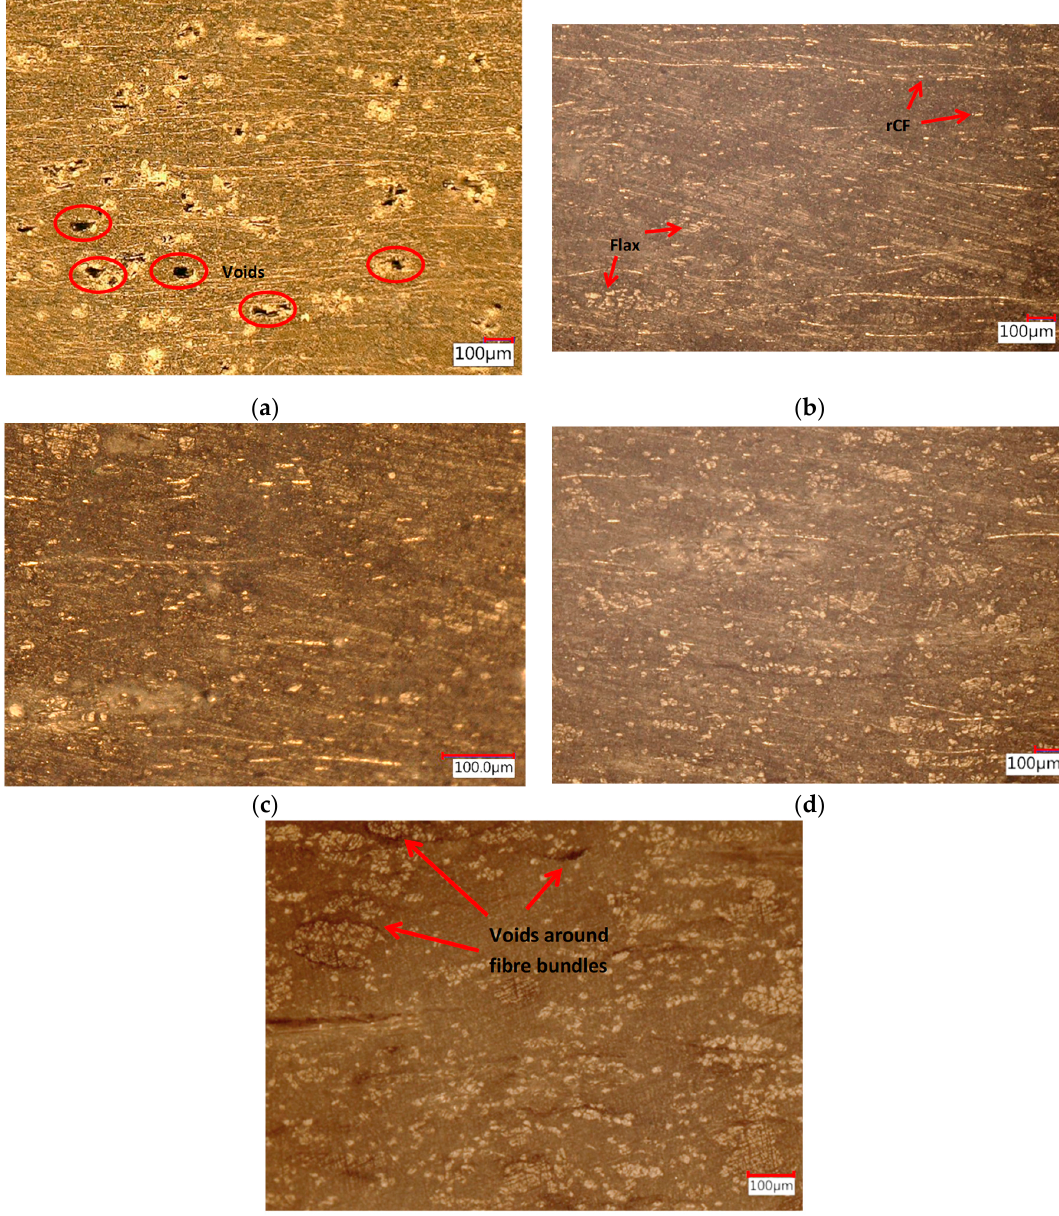
Figure 3. Optical micrographs with edge-lighting of the cross-section of ( a ) sample 1, 100% rCF; ( b ) sample 2, 75% rCF and 25% flax; ( c ) sample 3, 50% rCF and 50% flax; ( d ) sample 4, 25% rCF and 75% flax; and ( e ) sample 5, 100% flax.